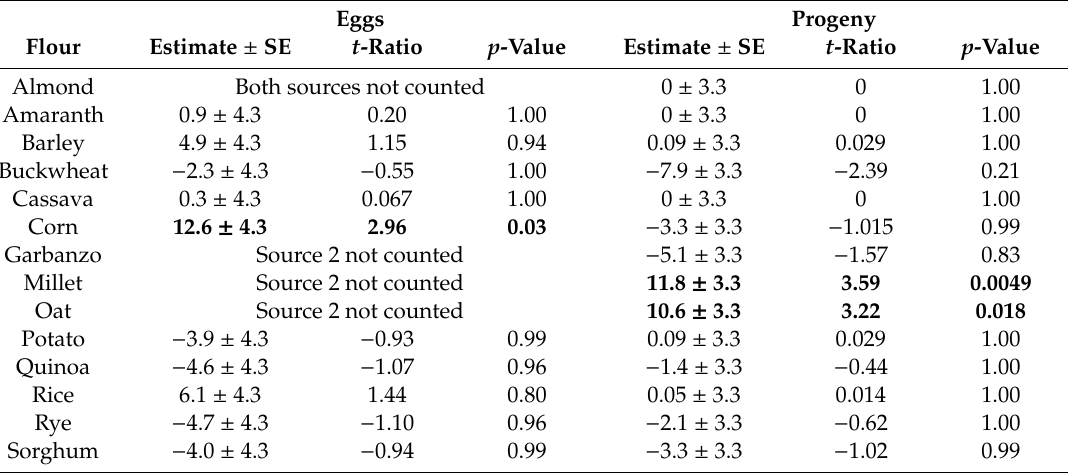
Table 2. Pairwise comparisons between each source for each flour. DF = 573 for eggs. DF = 2485 for progeny. Bolded text within the table represents significant di ff erences between sources.